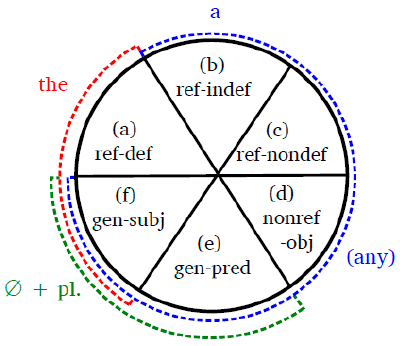
Figure 1. Givón’s Wheel Model, for English (redrawn). Figure 1. Giv ó n’s Wheel Model, for English (redrawn).